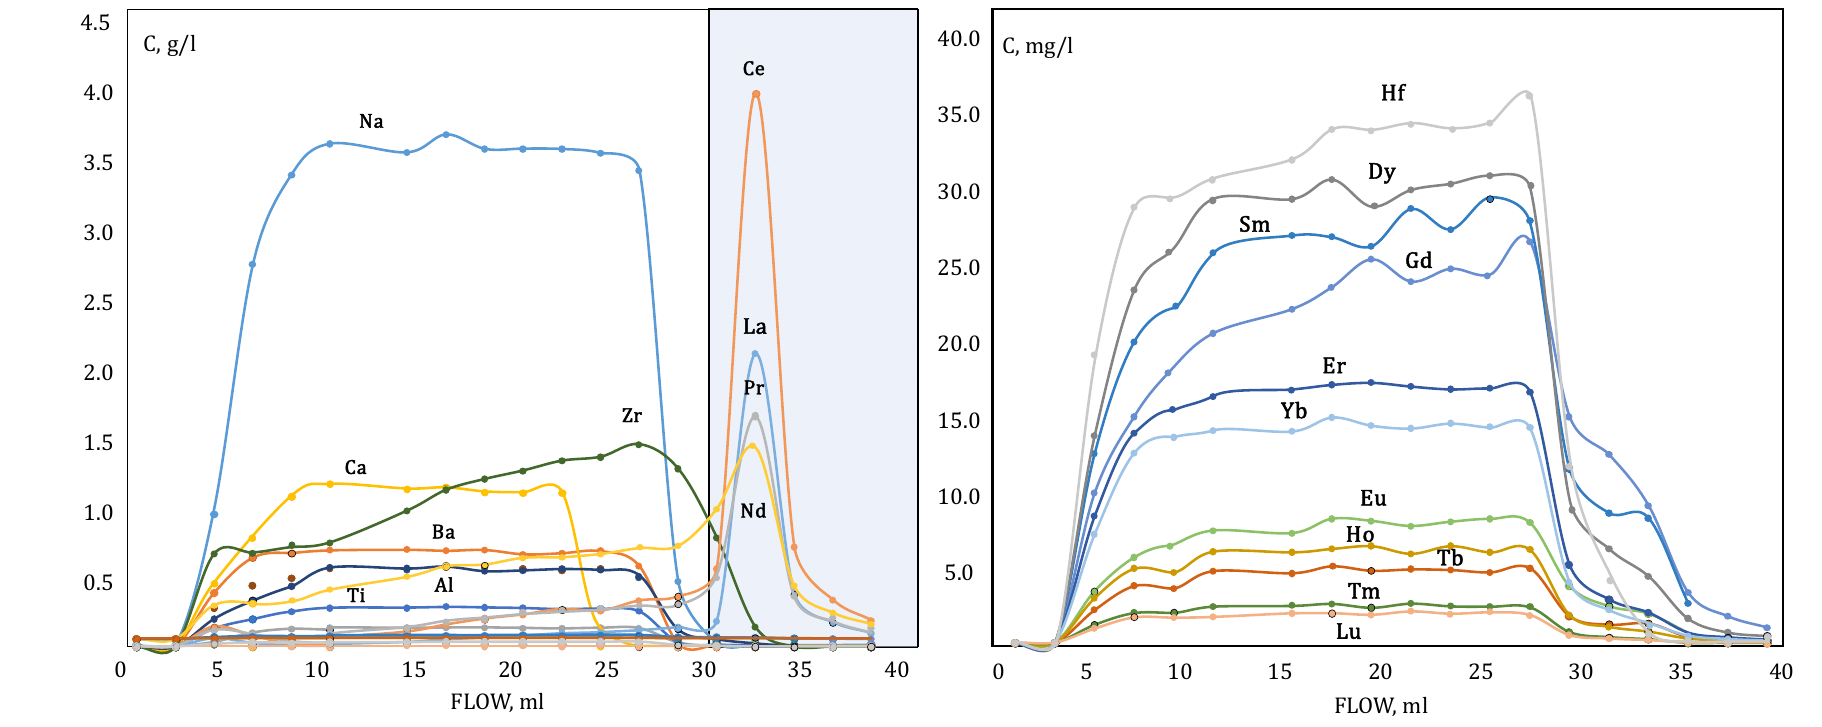
Figure 9. Pregnant solution elution curves through Dowex 1 × − 8 sorbent.